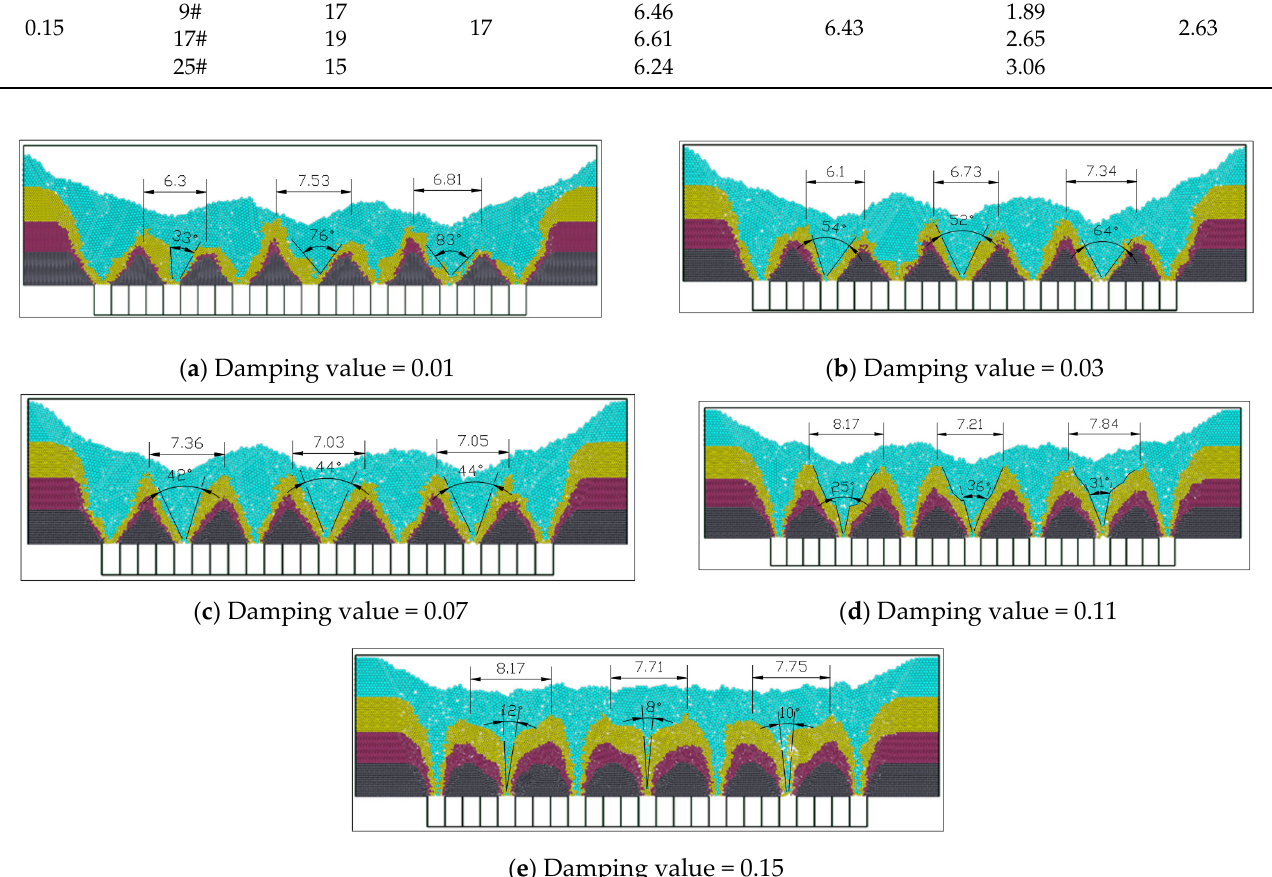
Figure 6. Rules of coal-rock interface of Level 2 under different damping values (The unit in the picture is meter). Table 4. Characteristics of top-coal drawing funnel after level 2 caving.